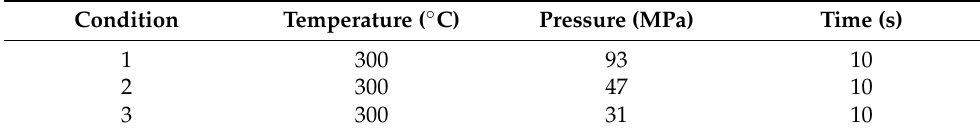
Table 2. Bonding conditions of the first step bonding process.